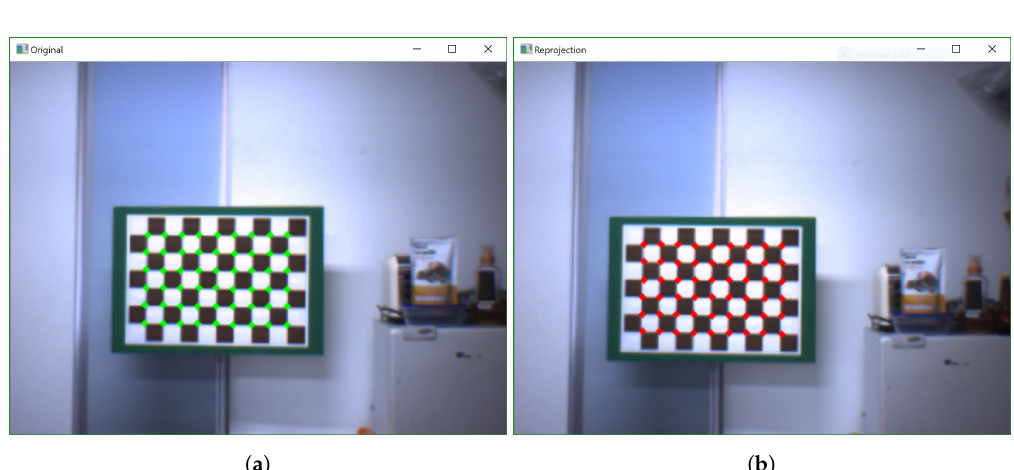
Figure 5. Reprojection results: ( a ) Reprojection of image i ; ( b ) transformed reprojection of image j